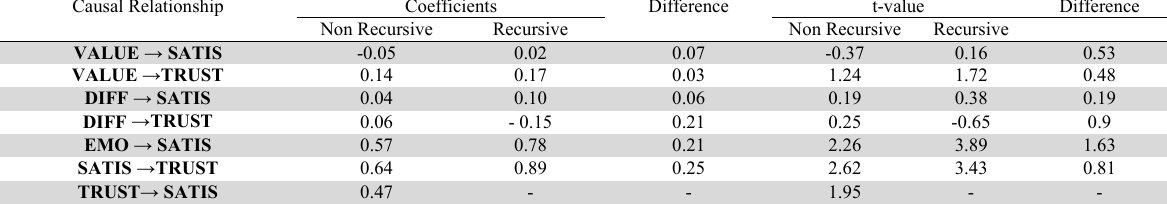
The difference of coefficients and t-count in non-recursive and recursive contexts Causal Relationship Coefficients Difference